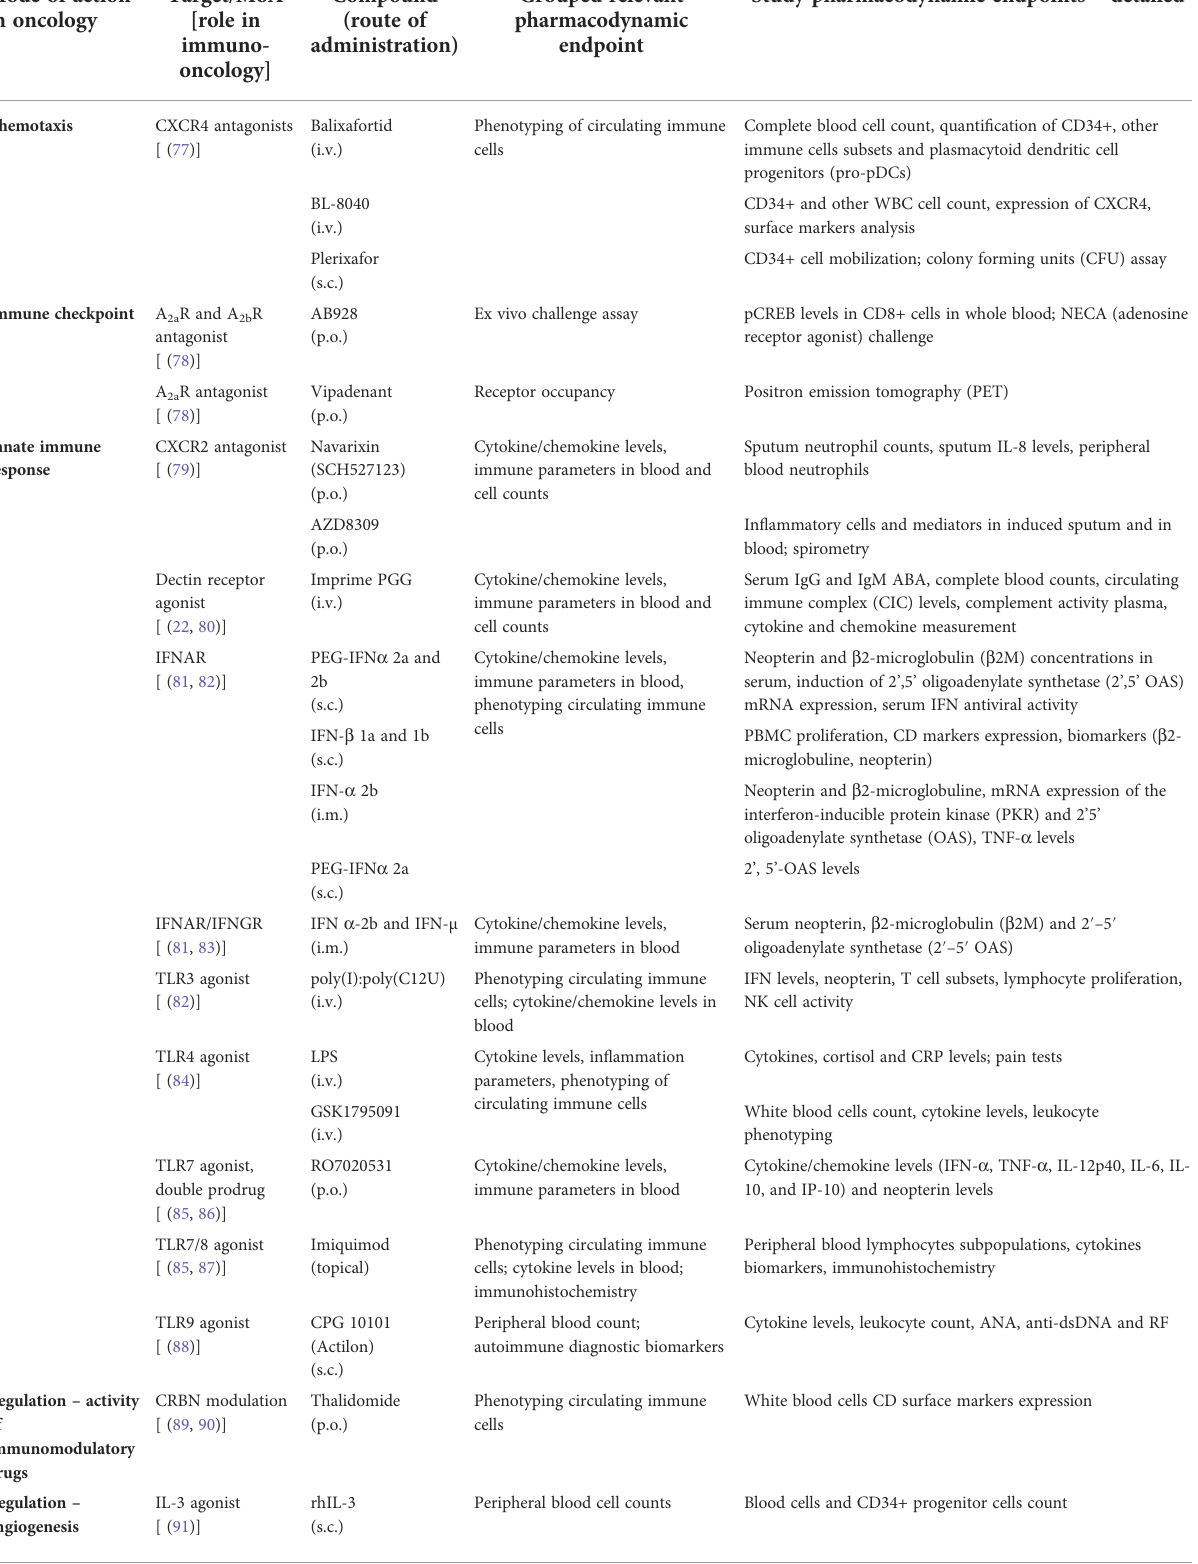
TABLE 4 Studies with pharmacodynamic endpoints possibly relevant for